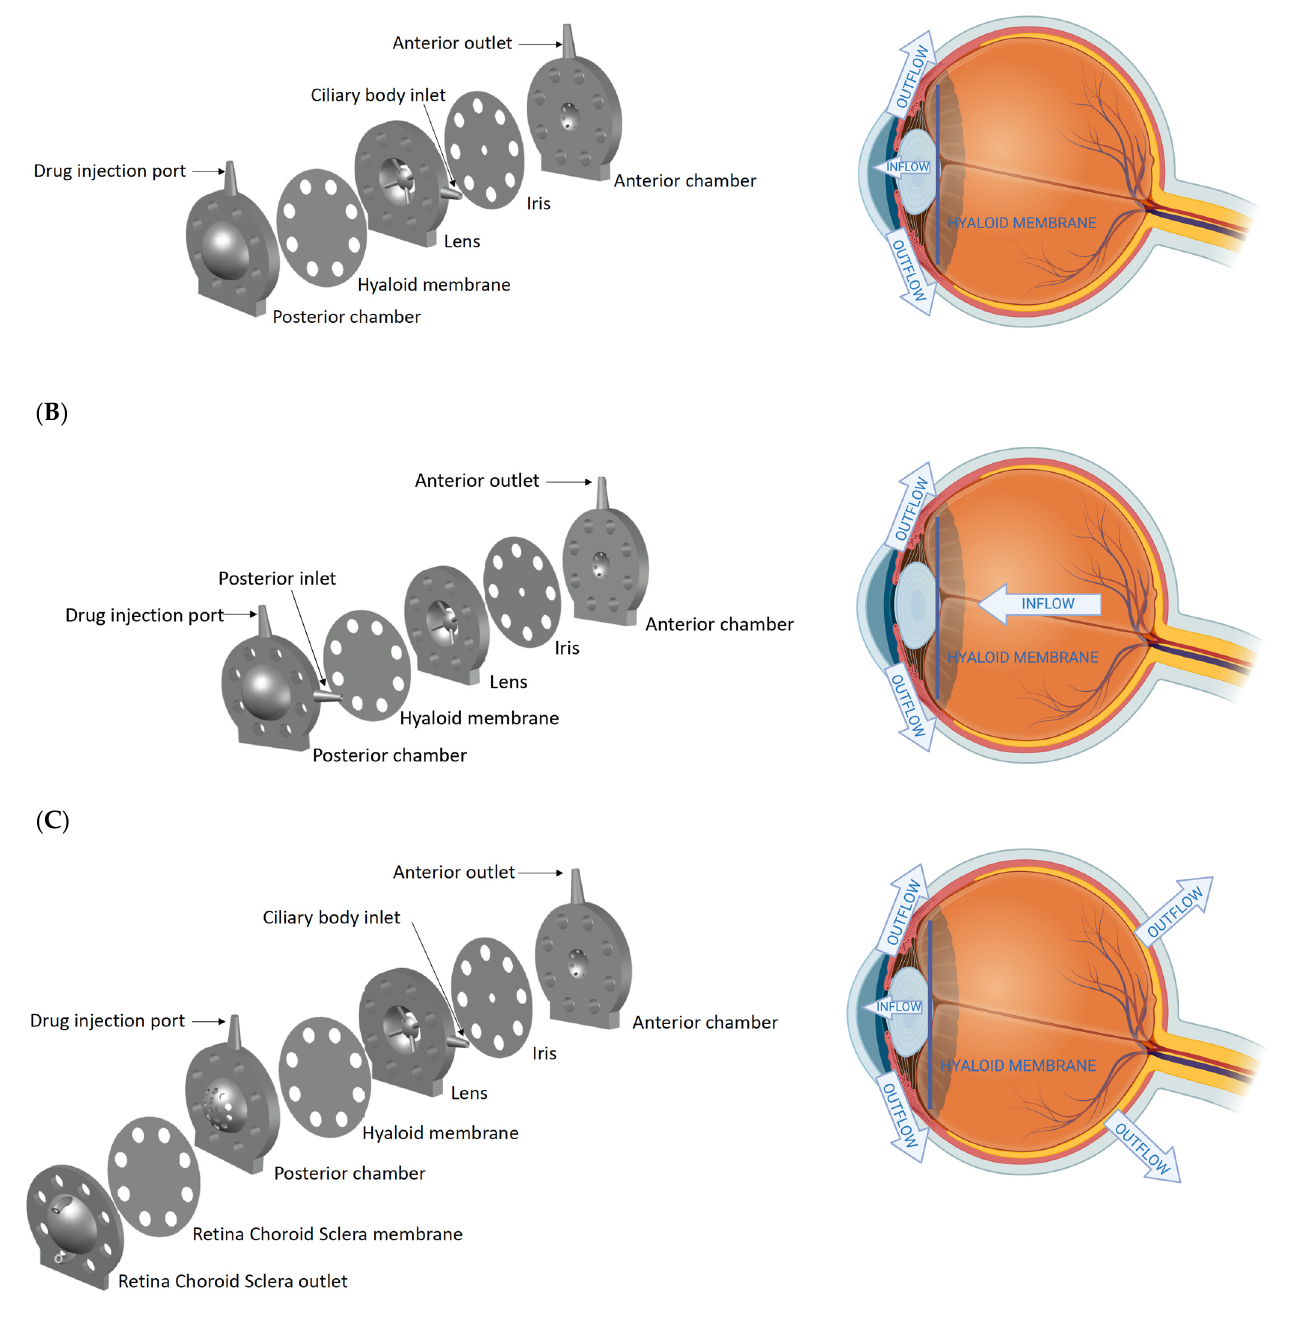
Figure 1. ( left panel ) CAD design and ( right panel ) inflow and outflow orientation (created with BioRender) of PK-Eye™ prototypes of ( A ) the ciliary inflow model, ( B ) posterior inflow model, and ( C ) ciliary RCS flow model.